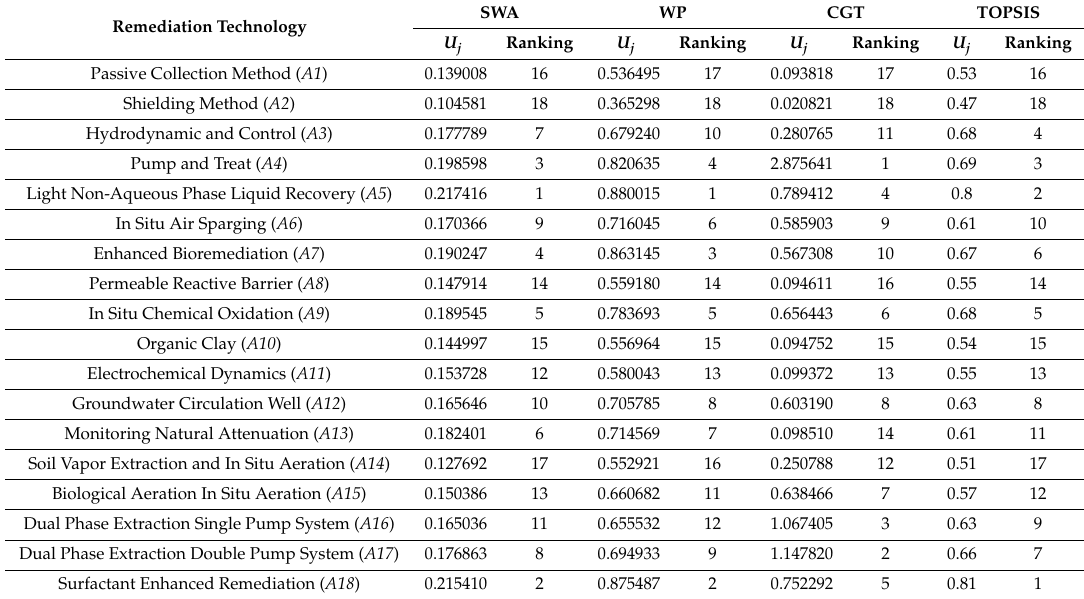
Table 7. Ranking results of the Simple Weighted Addition, Weighted Product, Cooperative Game Theory, and Technique for Order Preference by Similarity to Ideal Solution